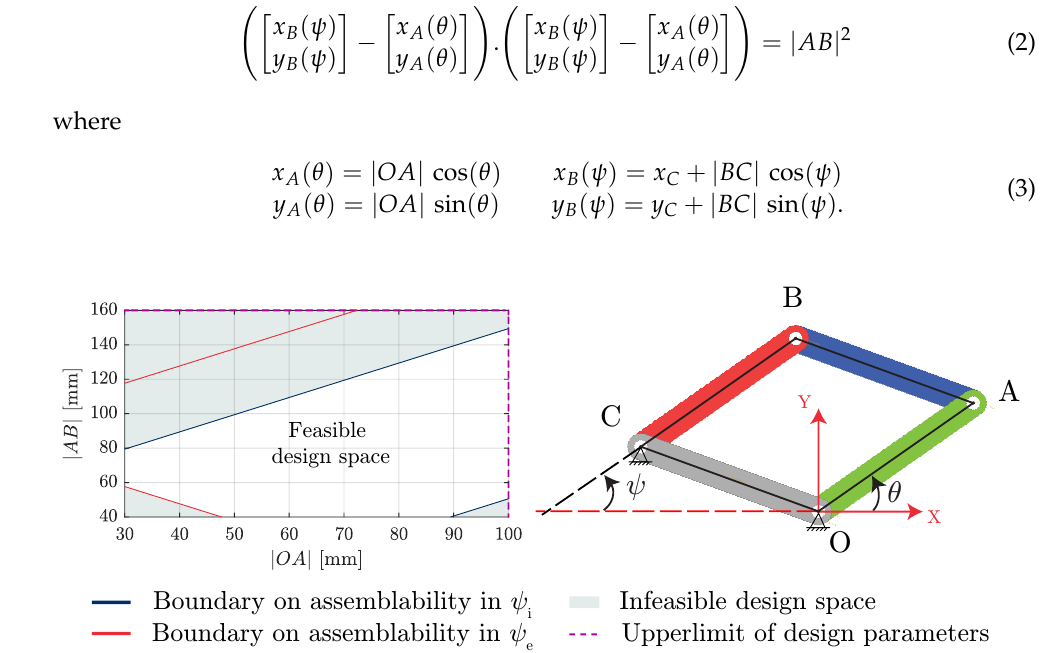
Figure 7. The static constraints ( left ), shown for 2 DPs, limit the design space to the area of the designs that reach the output link’s (BC) starting and ending position ( ψ i and ψ e